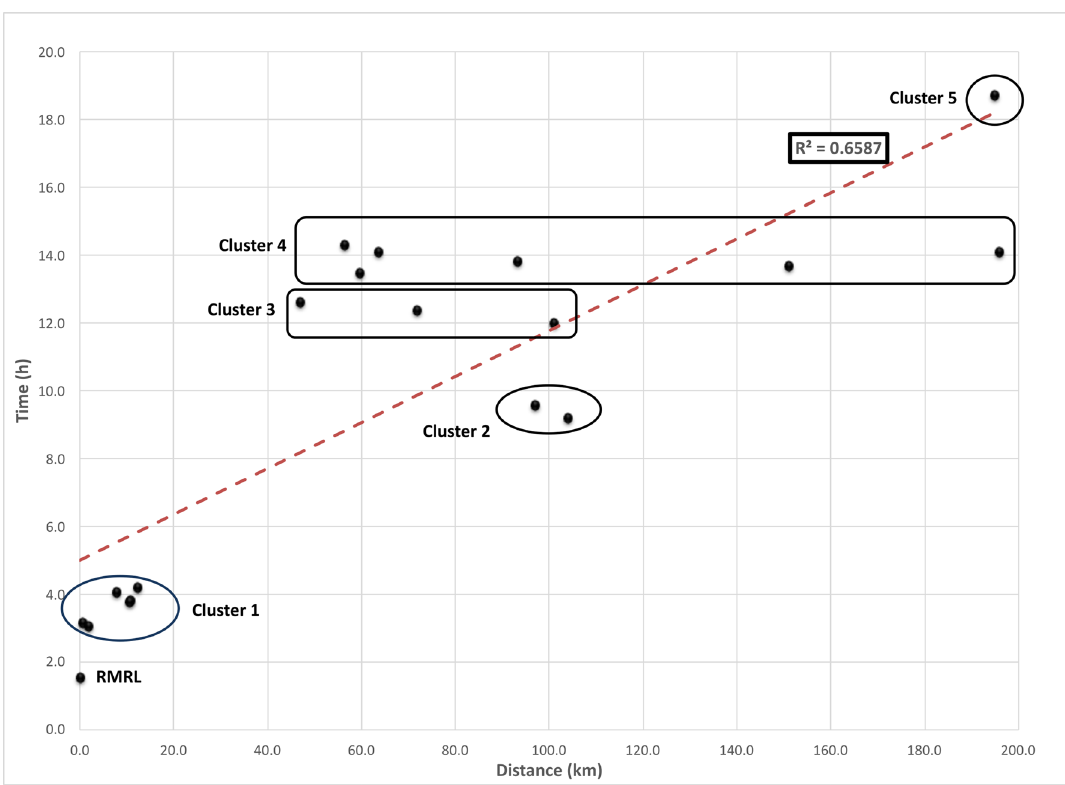
Figure 1. Median preincubation time as a function of distance travelled. Sites with similar median preincubation times were clustered as shown on the